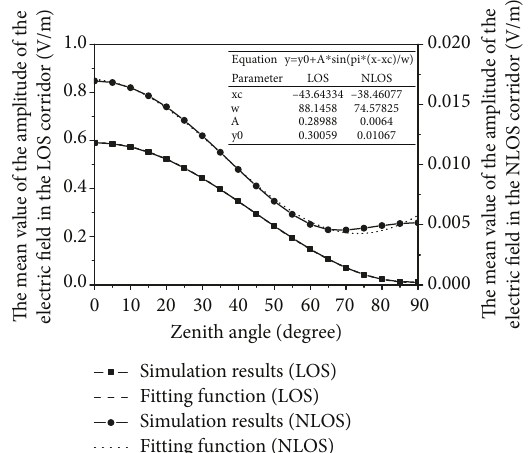
Figure 17: The statistical distribution of the phase of the electric fi eld for the LOS and NLOS